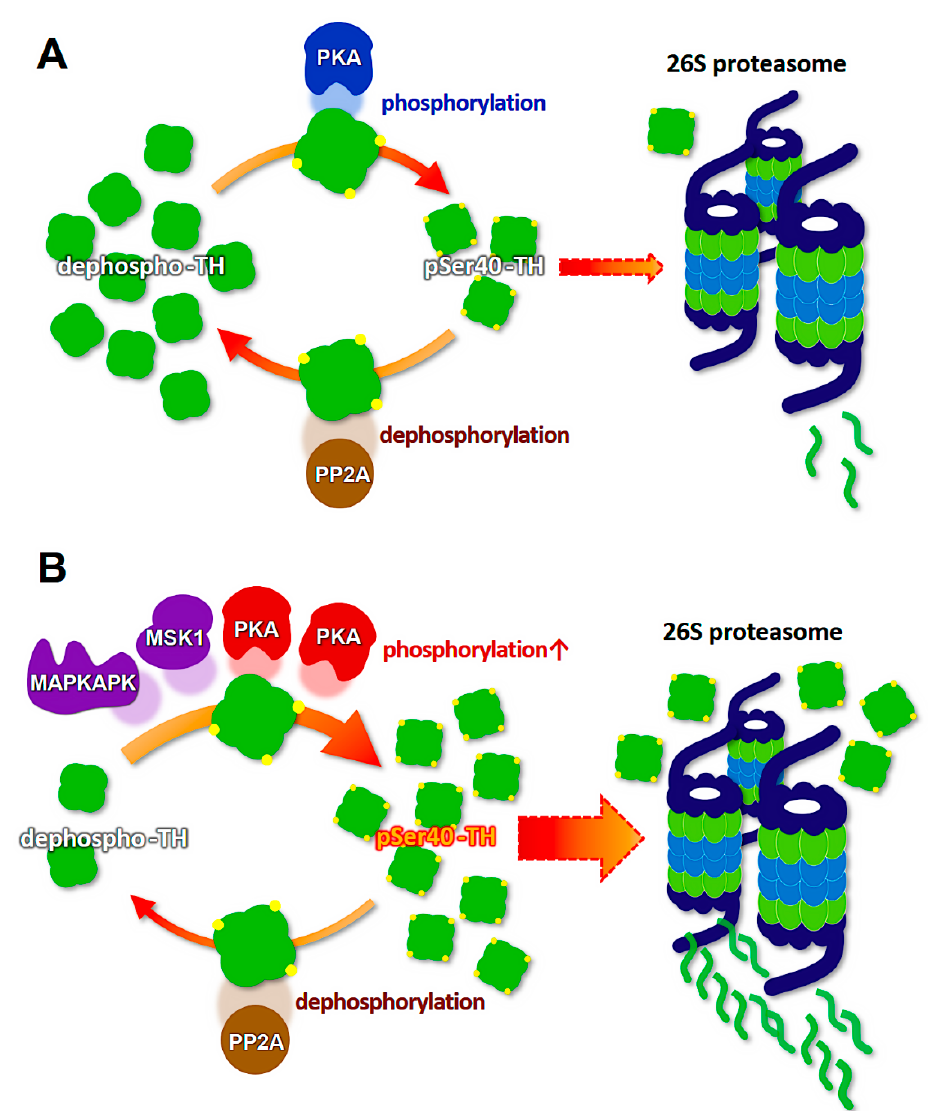
Figure 3. Schematic model of the molecular mechanism of the loss of tyrosine hydroxylase (TH) protein in the dopaminergic neurons. ( A ) A balanced state between the recycling TH protein and degrading TH protein. ( B ) Dopamine/biopterin deficient state activates PKA (red), and α -Synuclein aggregation presumably activates MAPKAPK and MSK1 (purple). Both activations accelerate TH phosphorylation (pSer40-TH), which is accompanied by proteasomal degradation. PKA, cAMP-dependent protein kinase; PP2A, protein phosphatase 2a. MAPKAPK, mitogen-activated protein kinase activated protein kinase; MSK1, mitogen- and stress-activated kinase 1.